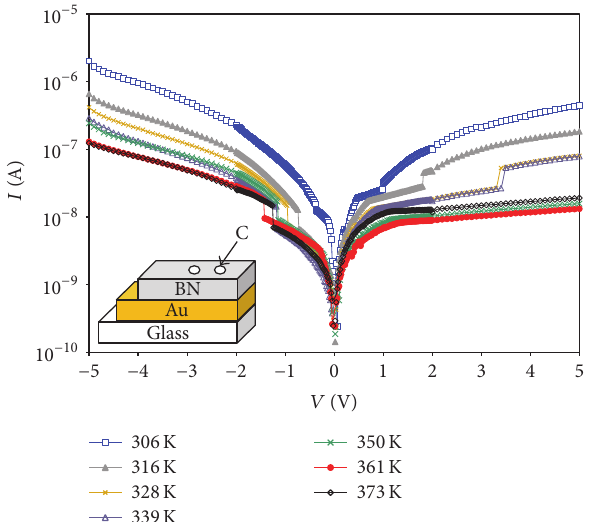
Figure 2: The 𝐼 - 𝑉 characteristics and geometrical design of Au/BN/C